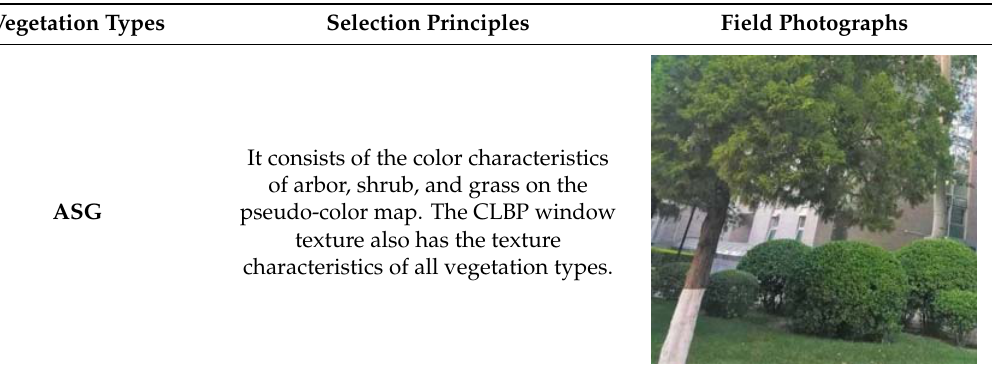
Table 6. The typical examples under different features of each vegetation type.